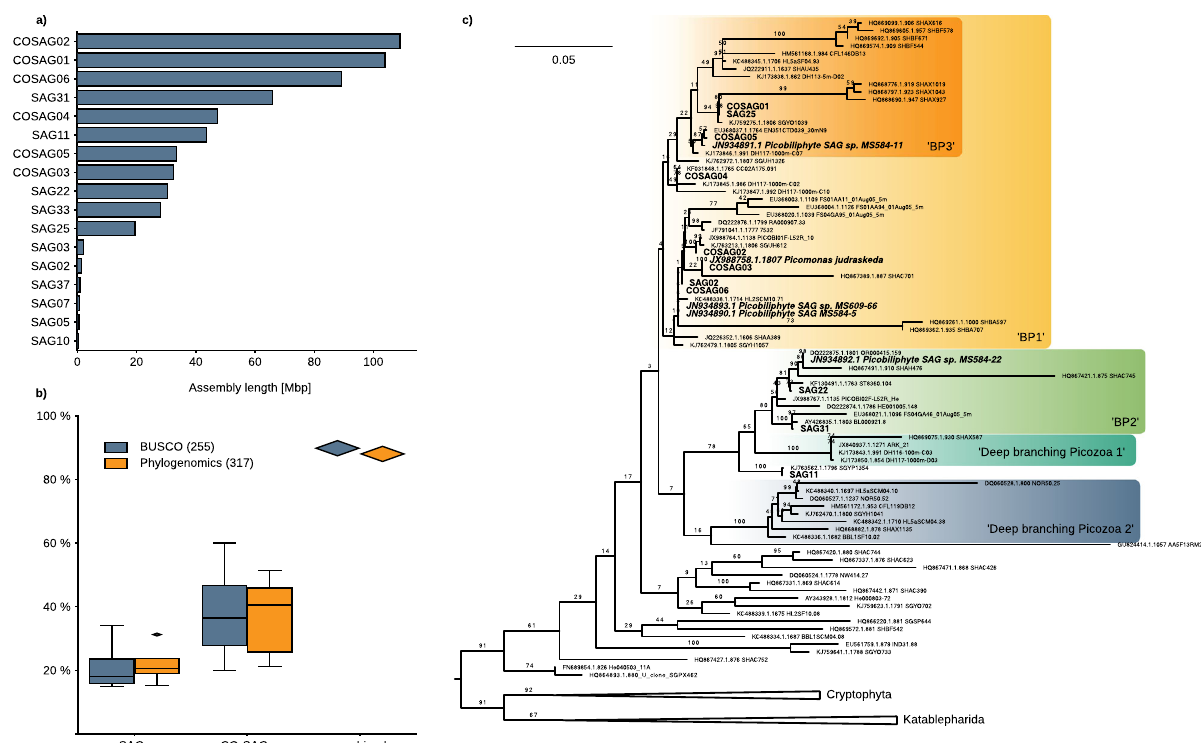
Fig. 1 Description and identi fi cation of single-cell genomes. a Assembly length in Mbp for 17 SAGs and CO-SAGs used for further analysis. Source data are provided in Supplementary Data 1. b Estimated completeness of the ten most complete SAGs ( n = 4) and CO-SAGs ( n = 6) as assessed using presence/absence of the BUSCO dataset of 255 eukaryotic markers and a dataset of 317 Phylogenomic marker genes. These ten assemblies were used for the phylogenomic inference. The boxes show the minimum and maximum (excluding outliers), fi rst quartile and third quartile as well as the median. Source data are provided in a Source Data fi le. c Maximum likelihood tree of the 18S rRNA gene, reconstructed using the model GTR + R4 + F while support was estimated with 100 non-parametric bootstrap replicates in IQ-TREE. Picozoa CO-SAGs and SAGs are written in bold, the sequences of Picomonas judraskeda and the SAGs from Yoon et al. 11 in bold italic. The group labels “ BP1-3 ” are taken from Cuvelier et al. 13 and “ deep-branching ” lineages from Moreira and López-Garcia 16